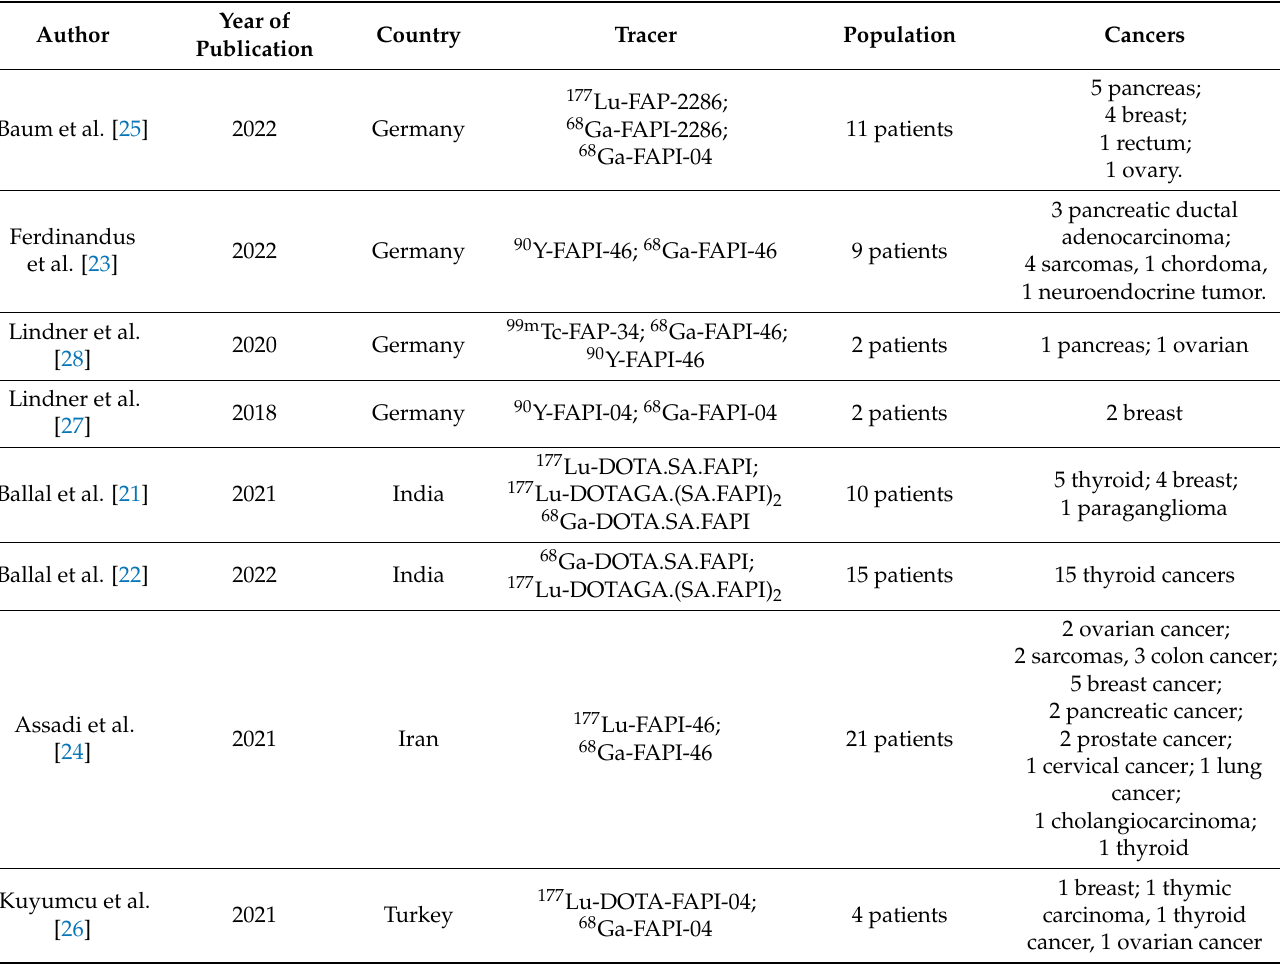
Table 2. Characteristics of studies.